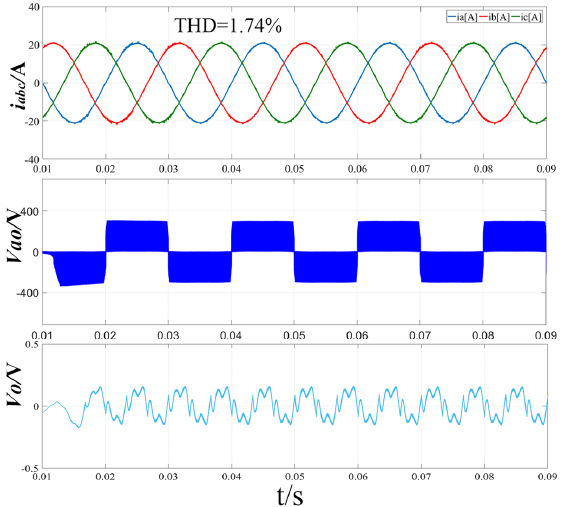
Figure 14. Simulation results of three-phase input current, line-to-neutral voltage and midpoint potential difference with improved hybrid modulation strategy (m = 0.86, Vdc = 600 V).